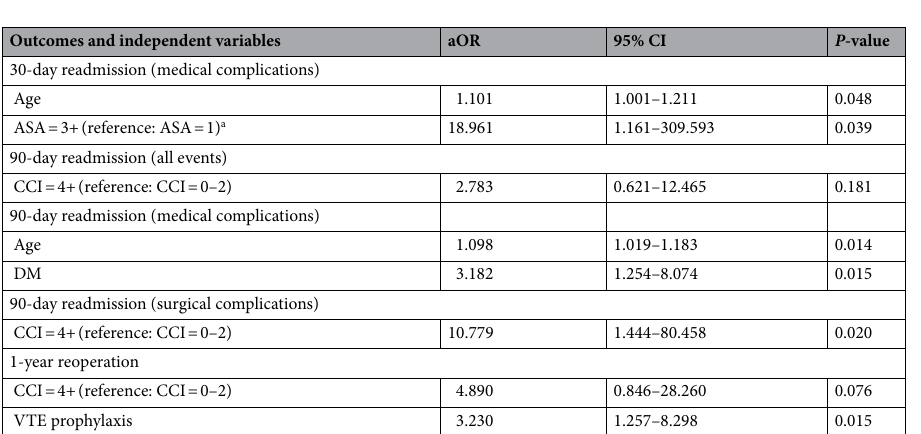
Table 3. Risk factors for postoperative readmission and reoperation events. aOR, adjusted odds ratio; ASA, American Society of Anesthesiologists classification; CCI, Charlson Comorbidity Index; CI, Confidence Interval; DM, diabetes mellitus; VTE: venous thromboembolism. a ASA = 2 (reference: ASA = 1): aOR (95% CI) = 5.187 (0.499–53.868), P -value =